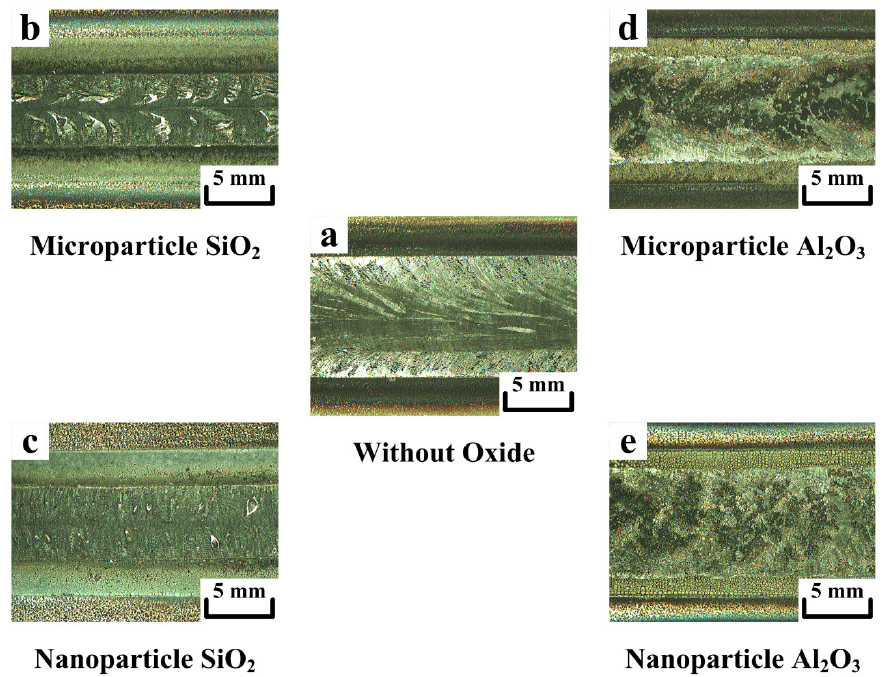
Figure 4. Surface appearance of TIG welds made with and without oxides.